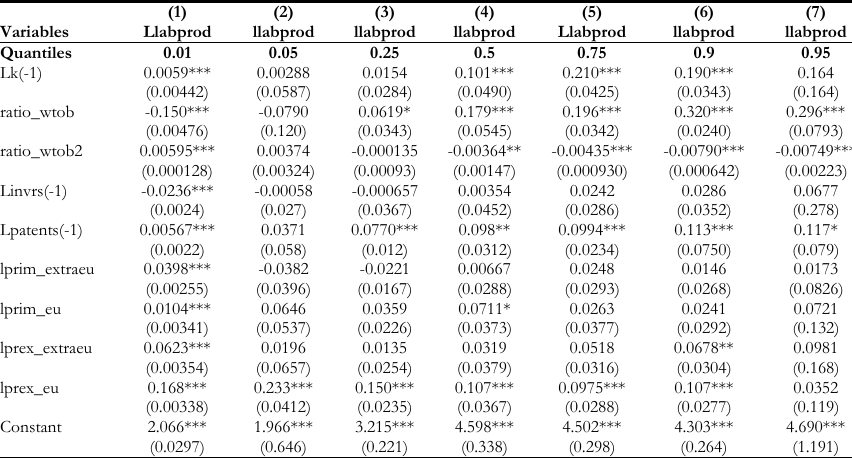
Quantile Regression Results for selected sectors: